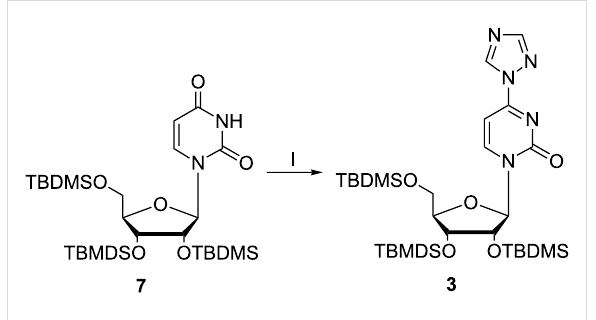
Figure 2: Introduction of the triazolyl moiety into the uridine derivative 7 generating synthon 3 . I: 4 equiv POCl 3 , 16 equiv triazole, 20 equiv NEt 3 , MeCN, 60 min at 0 °C, 4.5 h at rt,